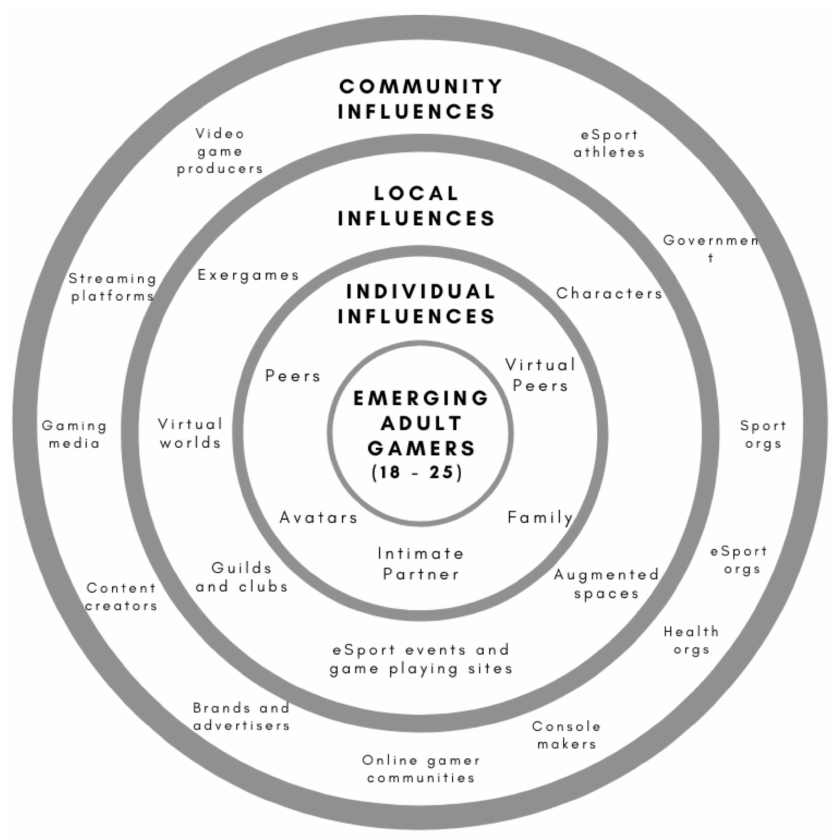
Figure 3. Behavioural ecological map of influences that intersect with EAs in online